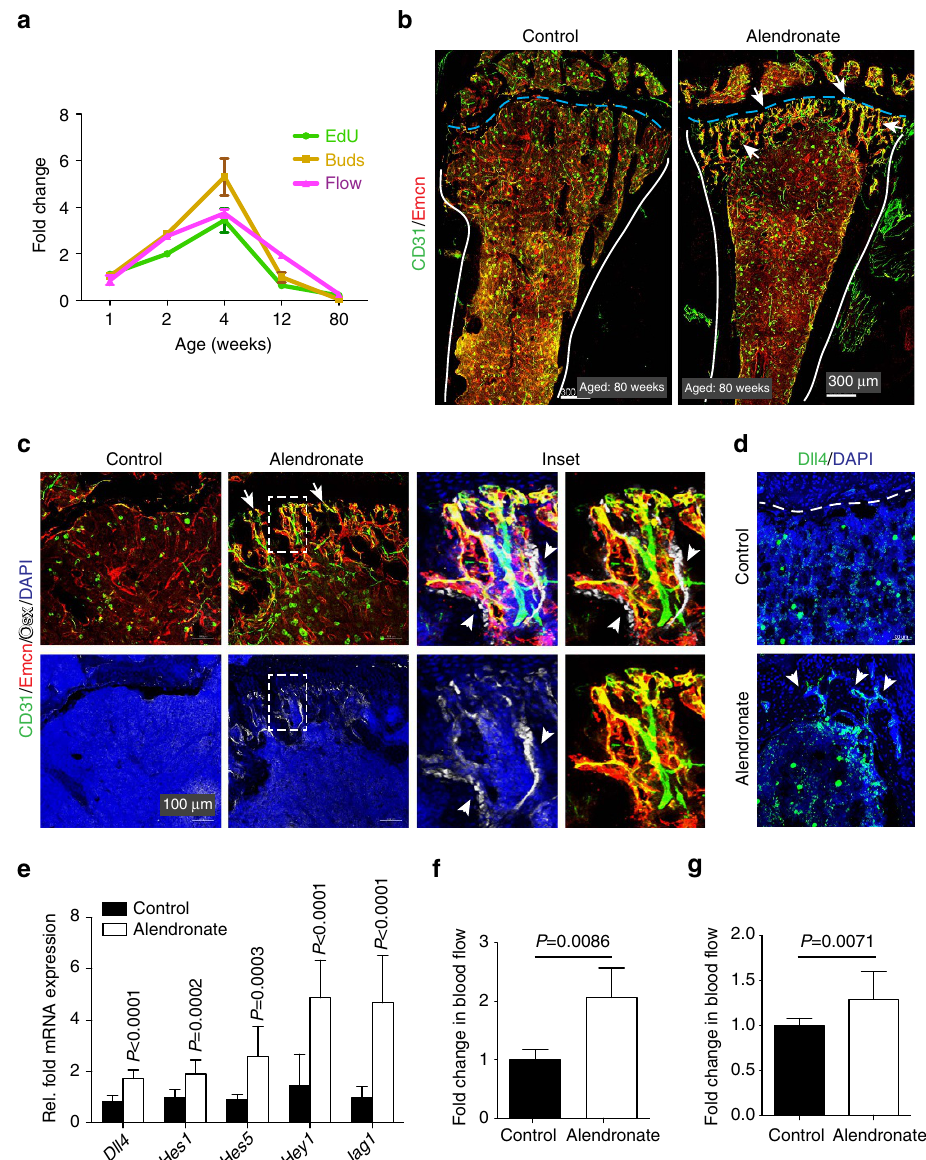
Figure 6 | Alendronate stimulates endothelial Notch signalling and flow in bone. ( a ) Graph showing age-dependent changes in EdU þ ECs and bud structures in distal tibia. Blood flow measurements in the same age groups indicate a similar pattern. Data represent mean ± s.d. ( n ¼ 5 biological replicates). P values, two-tailed unpaired t test. ( b ) Tile scan images of tibia from control and Alendronate-treated 80-week-old mice. Sections were immunostained for CD31 (green) and Emcn (red). Note appearance of CD31 þ blood vessels (arrows) in Alendronate-treated metaphysis. ( c ) Vascular front in sections of control and Alendronate-treated aged tibia immunostained for CD31 (green), Emcn (red) and Osterix (Osx, white). Nuclei, DAPI (blue). Inset shows CD31 þ blood vessels in close proximity to osteoblasts. ( d ) Confocal images showing metaphysis of aged mice after Alendronate administration. Immunostaining shows endothelial Dll4 (green). Nuclei, DAPI (blue). ( e ) qPCR analysis of Dll4 , Hes1, Hes5, Hey1 and Jag1 transcripts expression in ECs sorted from control and Alendronate-treated 80-week-old long bone. Data represent mean ± s.d. ( n ¼ 6 biological replicates). P values, two-tailed unpaired t test. ( f ) Increased blood flow in tibia of Alendronate-treated aged (80-week-old) mice. Data represent mean ± s.d. ( n ¼ 6 biological replicates). P values, two-tailed unpaired t test. ( g ) Blood flow measurements in tibia after short-term treatment with Alendronate. Data